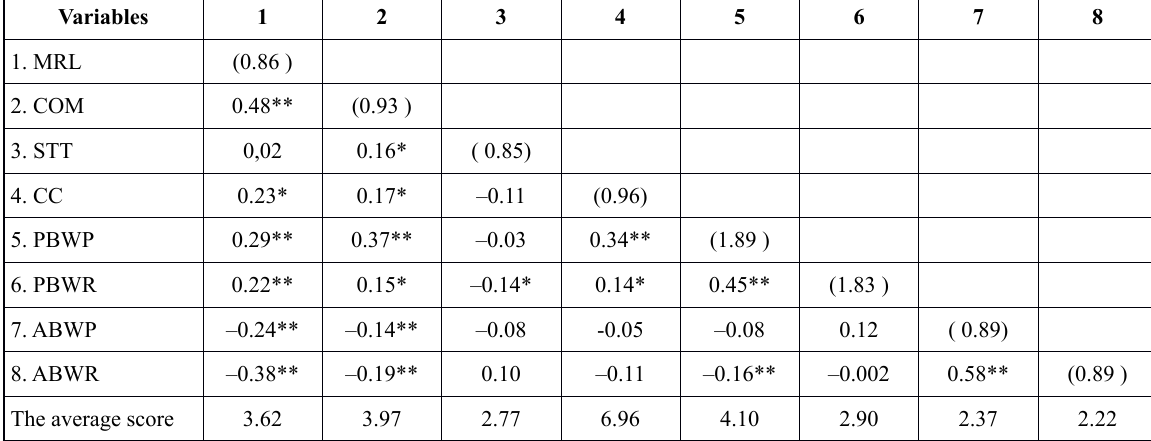
Table 3. Correlations, scale compatibility, and the main results of the study. Cronbach’s alpha are reported on the diagonal